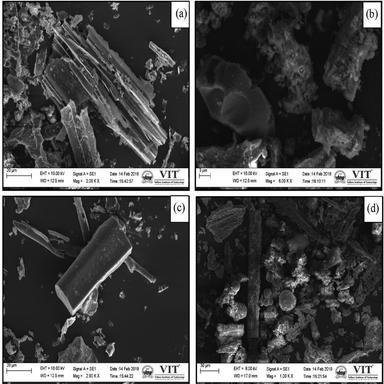
SEM images of SCBA grains (a) Unburnt bagassse fibre (b) Amorphous particle (c) Prismatic particle (d) Particles in different shapes.